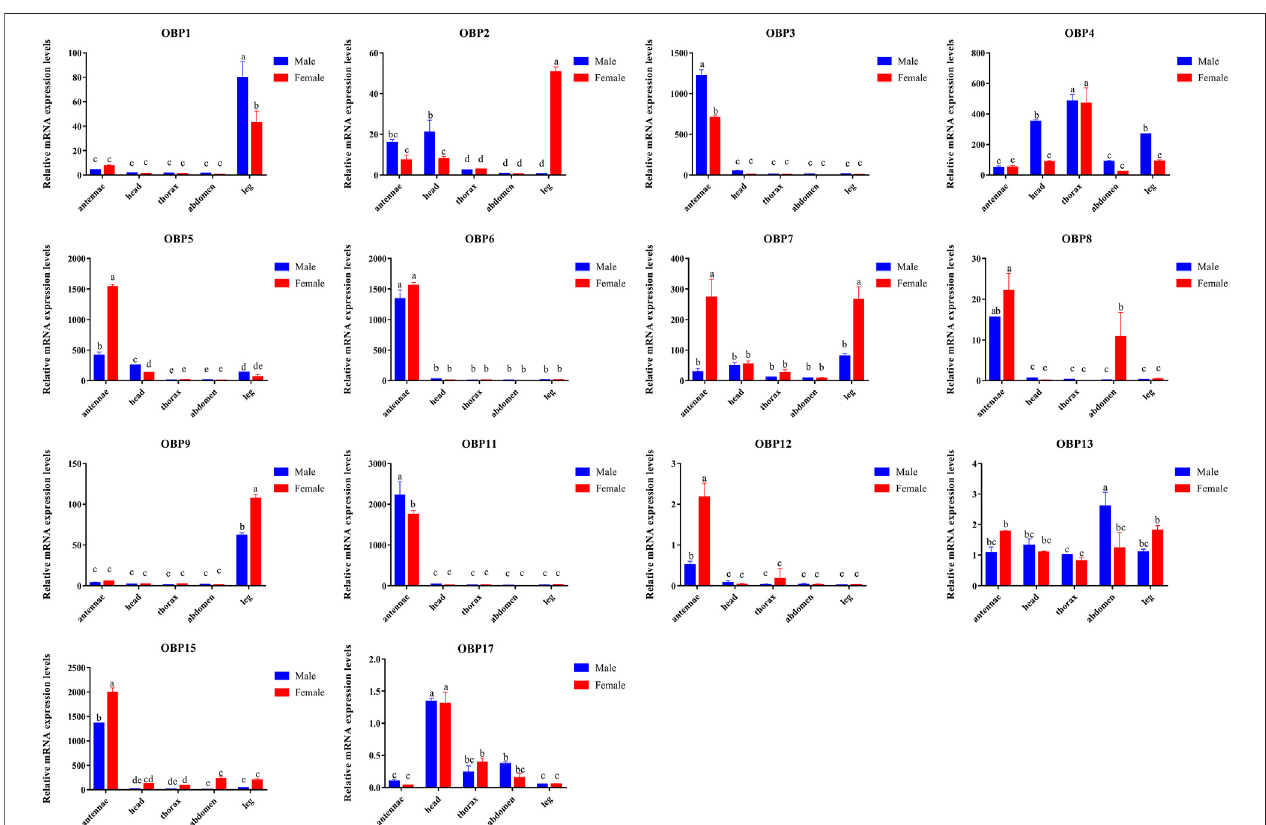
FIGURE 4 | Relative expression of AgifOBP genes in the different tissues of male and female A. gifuensis as measured by quantitative real-time polymerase chain reaction. Relative fold changes were normalized to the transcript levels in the male thorax. The NADH and ACTIN genes were used as references to normalize the expressionofeachtestedgene.Thestandarderrorisrepresentedbytheerrorbar( n =3)andthedifferentlowercaseletters(a,b,c,d,e)indicatesigni fi cantdifferencesin transcript abundances (two-way ANOVA followed by Tukey ’ s HSD multiple comparison test, p <